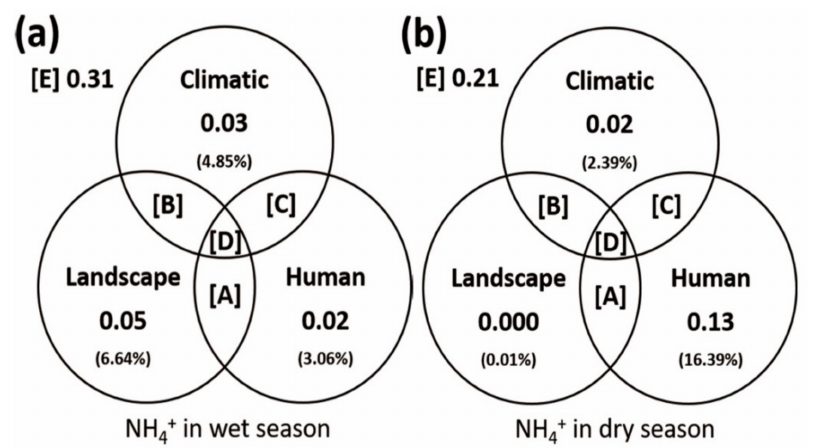
Figure 8. Variance decomposition (conditional e ff ects) of NH 4 + exports in wet ( a ) and dry ( b ) seasons in 43 watersheds. Each circle and the intersections indicate the individual e ff ect of climatic [C], landscape (L) and human disturbance (H) variables and their interactive e ff ects on NH 4 + export from pRDA, including the shared variance of landscape setting and human disturbance (LH) [A], landscape setting and climatic variables (LC) [B], climatic variables and human disturbance (CH) [C], among three variables (CLH) [D], and residual variance [E]. In Panel ( a ): [A] = 0.61 (88.54%); [B] = − 0.004 ( − 0.56%); [C] = 0.001 (0.09%); [D] = − 0.02 ( − 2.62%). In Panel ( b ): [A] = 0.64 (80.70%); [B] = 0.001